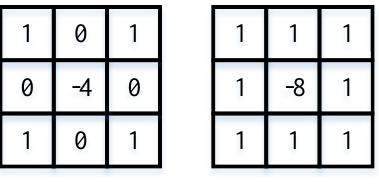
Figure 2. Extension template of Laplace